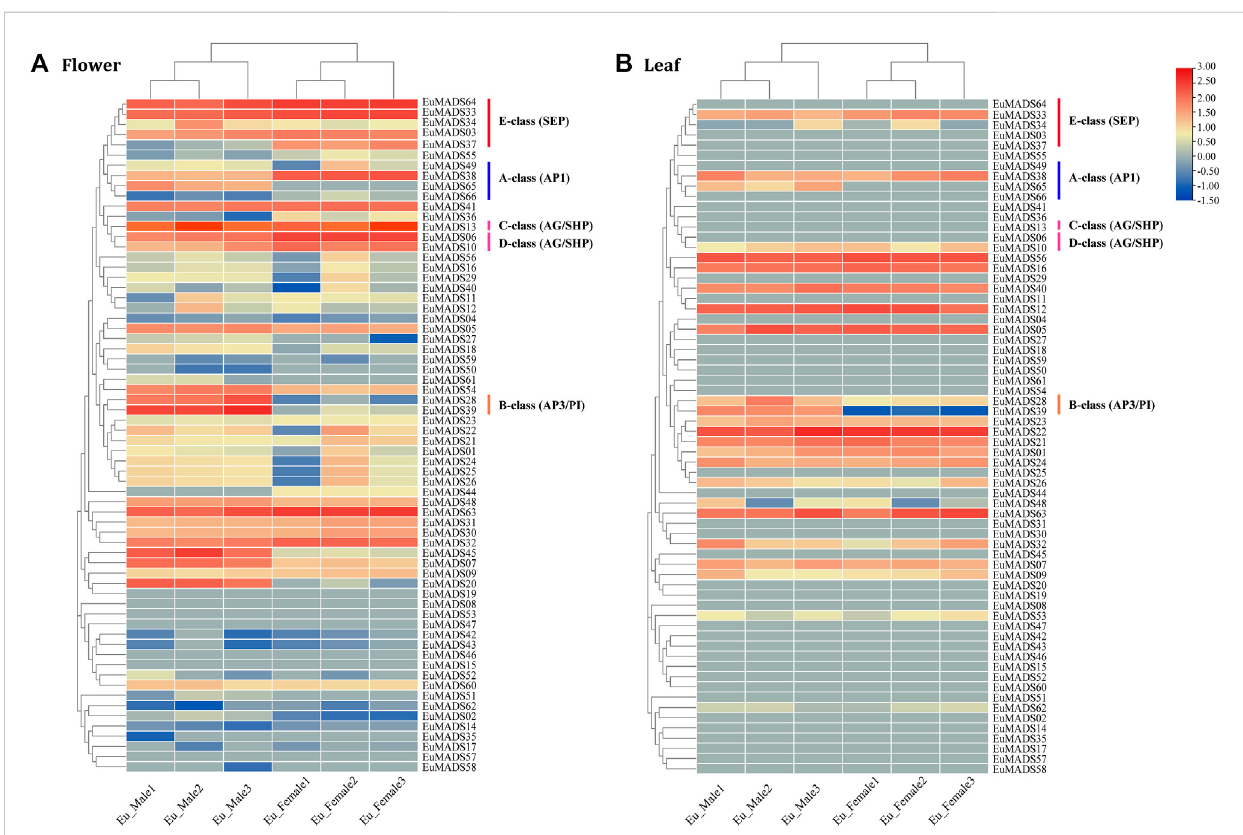
FIGURE 7 Expression pro fi ling of EuMADS genes in tissues of (A) fl ower and (B) leaf. FPKM values of 66 EuMADS genes were calculated using transcriptome